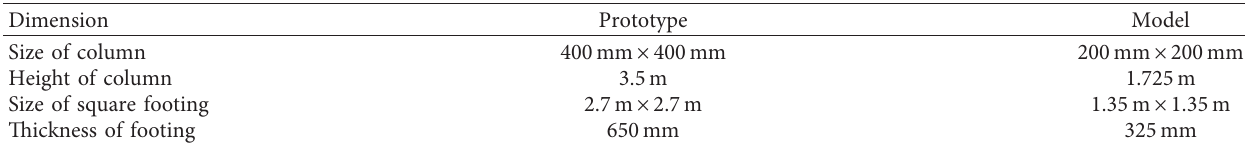
Table 2: Dimensions of the prototype and